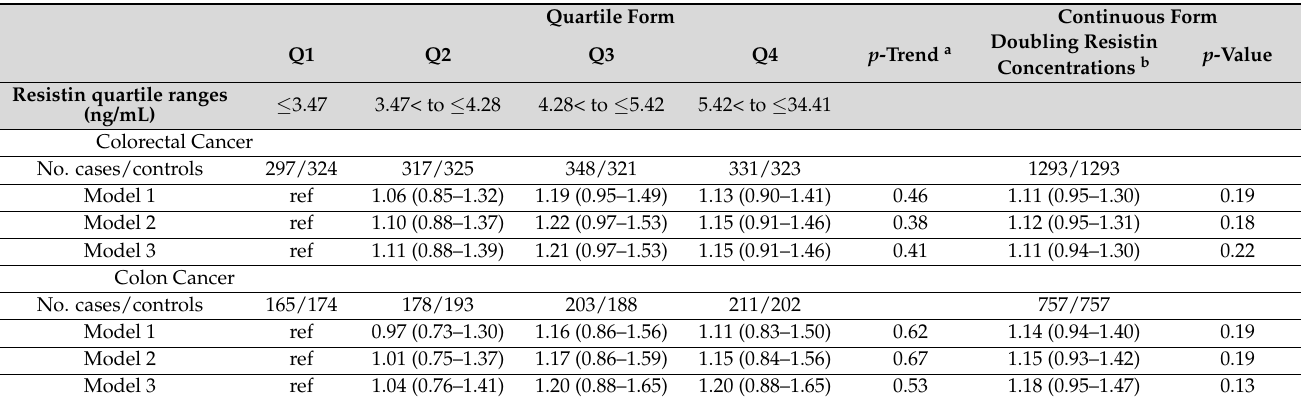
Table 3. Relative risk (RR) and 95% confidence interval (95% CI) estimated for the association between resistin concentrations and the risk of colorectal cancer in the EPIC study data (1992–2005) in conditional logistic regression models. Quartile